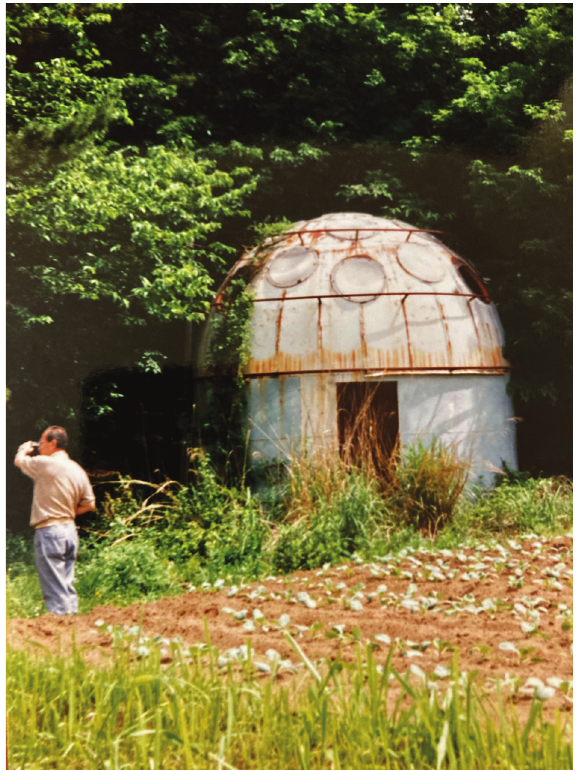
Figure 2. Japanese air-fluorescence prototype building. On the left is Prof.